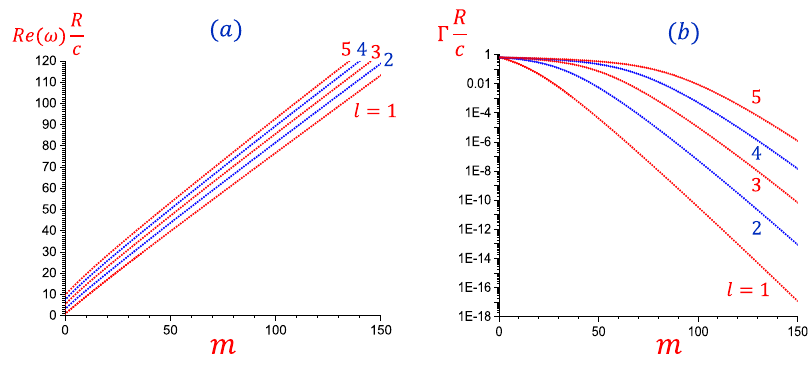
number l = 1, 2, 3, … . The radial quantum number l determines the number of fi eld oscillations inside the cylinder. In Figure 9, we plot the normal mode frequencies (a) and their decay rates (b) as functions of the angular quantum number m for l = 1, 2, 3, 4, and 5. In these calculations, we assume that cylinder ’ s refractive index is n = 1.4. The vertical axis in Figure 9b has a logarithmic scale.